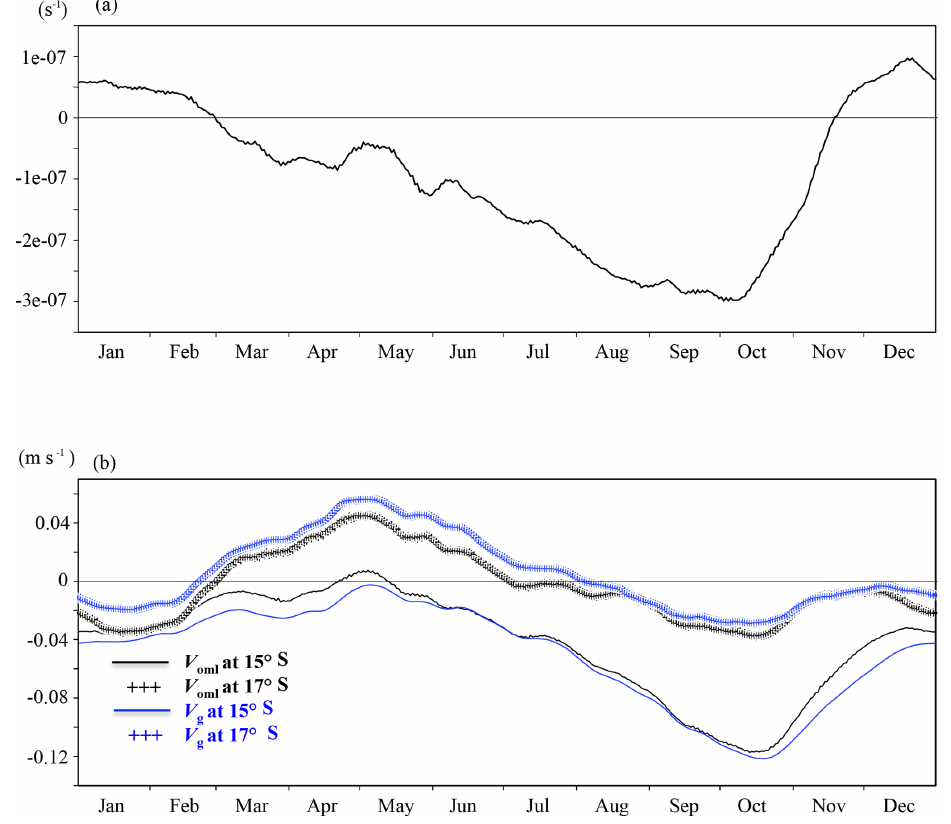
Figure 6. Time series of (a) averaged over (17–15 ◦ S and 10–12 ◦ E) and (b) OML-mean meridional current velocity (black) and geostrophic meridional current velocity estimated from sea surface height (blue) at 15 ◦ S (solid line) and 17 ◦ S ( + mark) averaged between 10 and 12 ◦ E. All variables are filtered by a moving 11-day